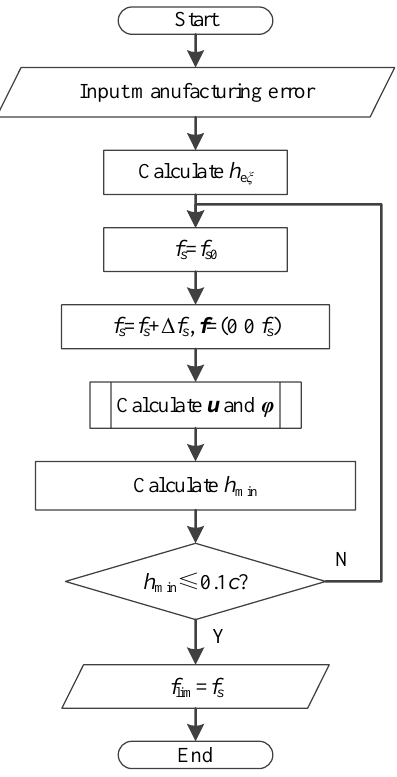
Figure 9. Program flow chart for calculating overload limit.